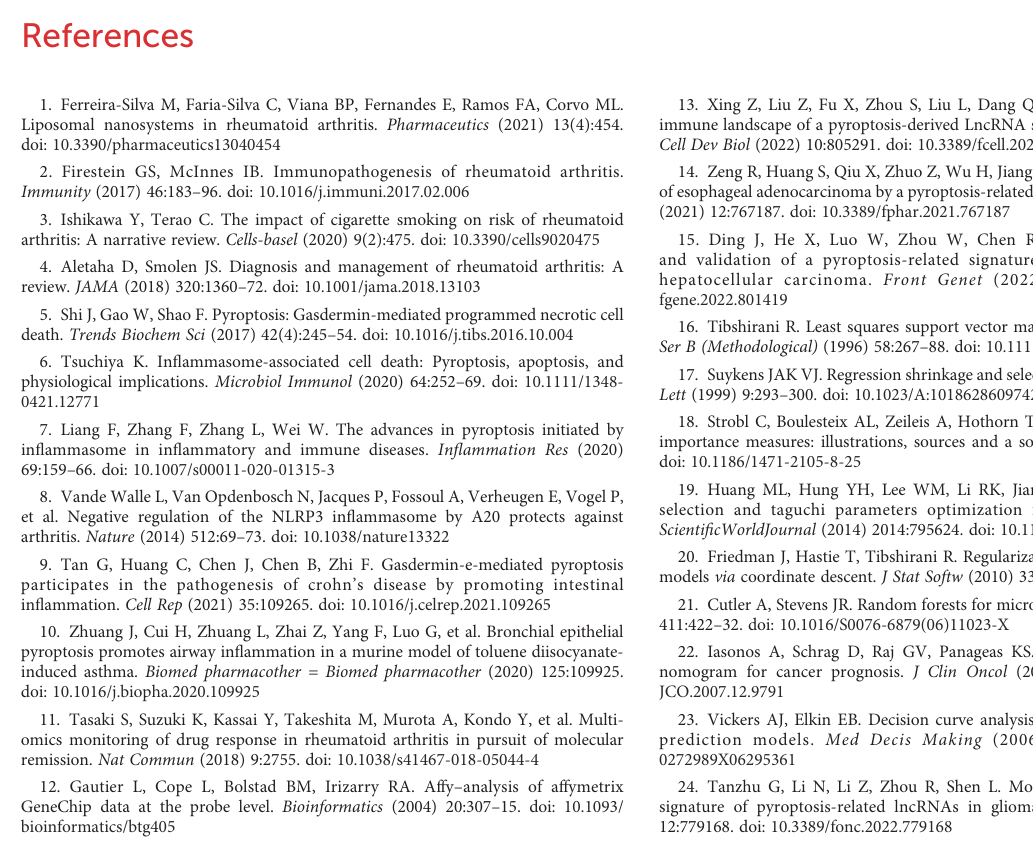
SUPPLEMENTARY TABLE 3 The details of GO analysis. SUPPLEMENTARY TABLE 4 The details of KEGG